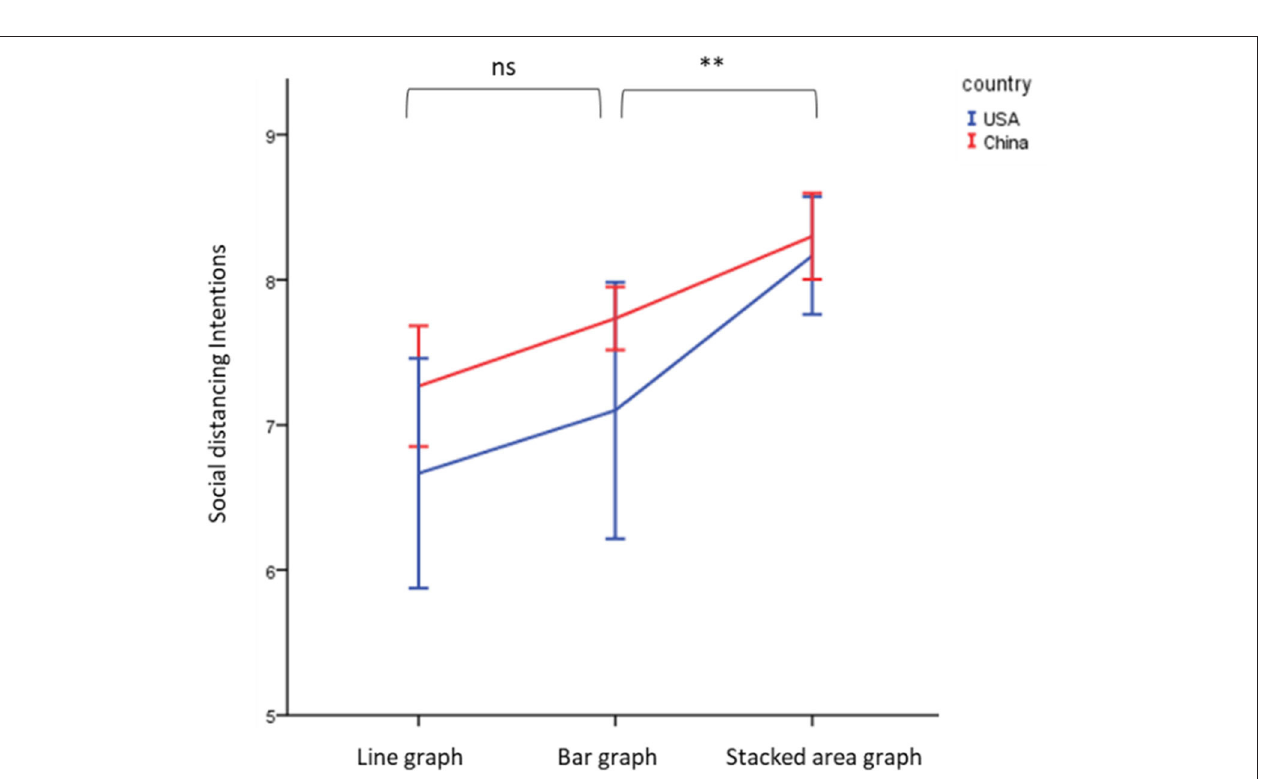
FIGURE 4 | Effect of different graphs and cultures on social distancing intentions. **Significant at 0.05; ns, non-significant.